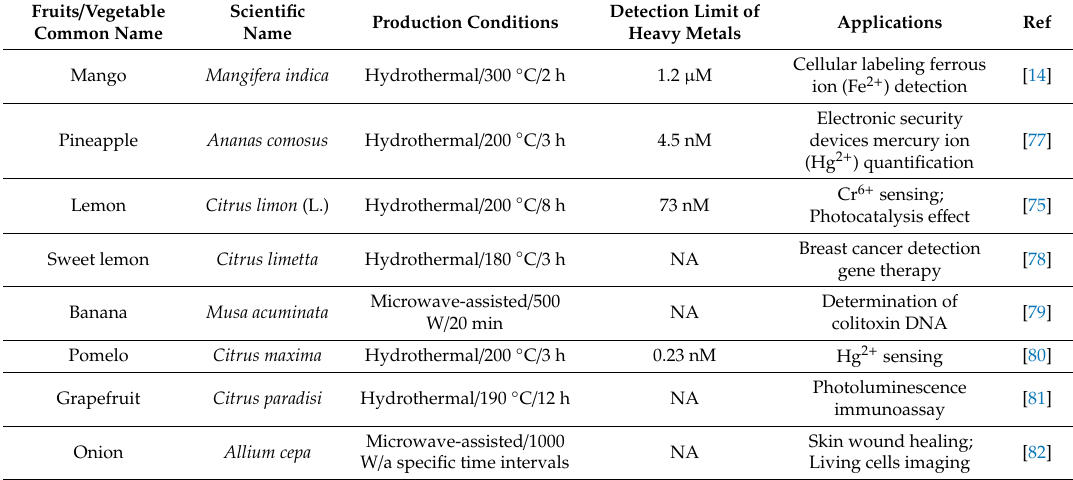
Table 3. Fruits and vegetables peel as a carbon source for preparing carbon